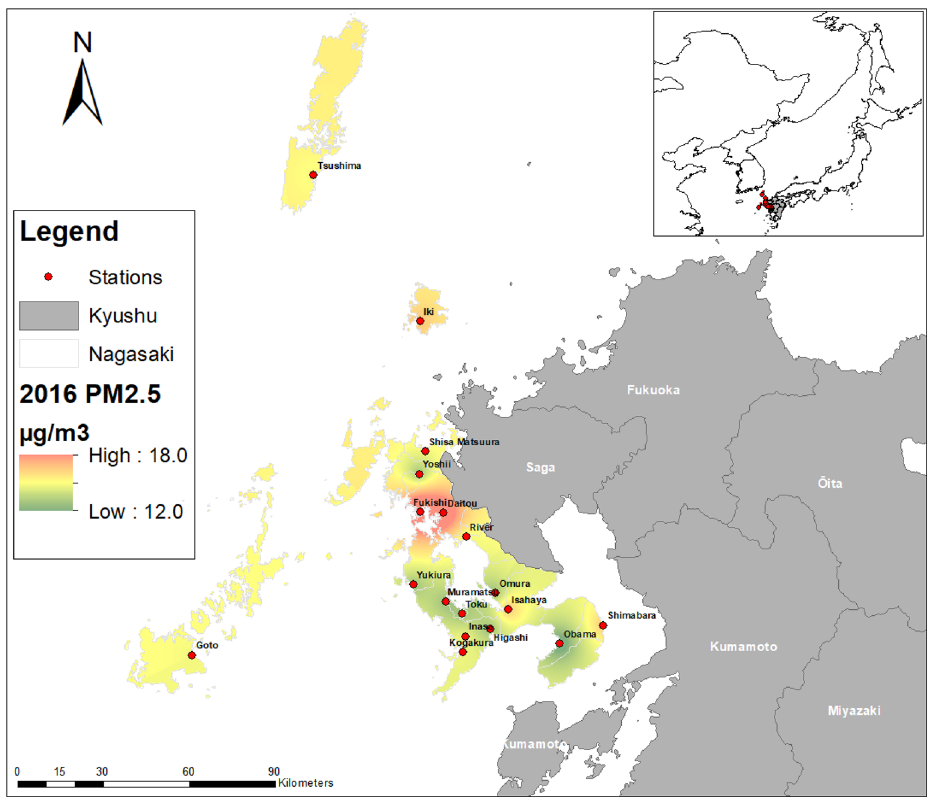
Figure 7. Study site and air pollution monitoring stations in Nagasaki Prefecture, Japan. Created with ArcMap 10.7 (https:// www. arcgis. com/ index.